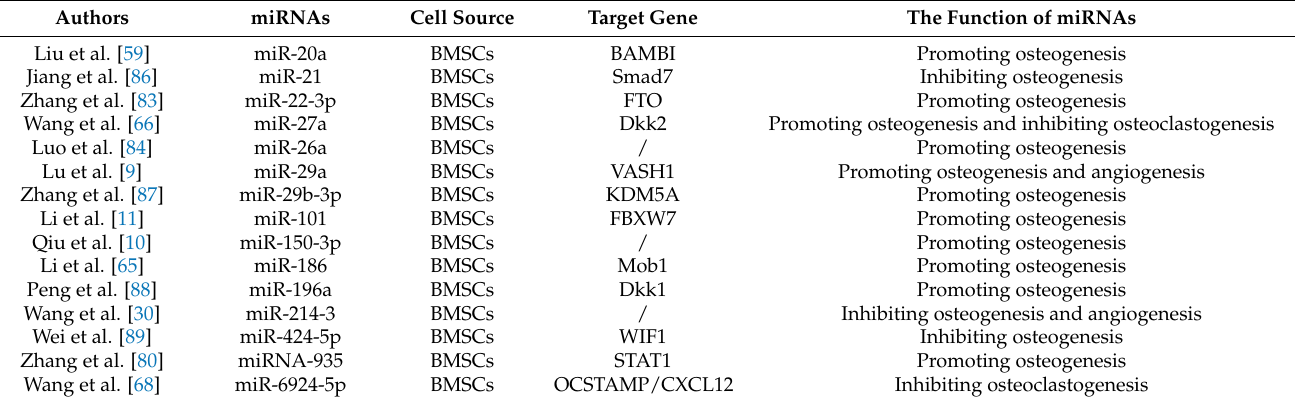
Table 1. BMSC-EV-miRNAs regulate bone